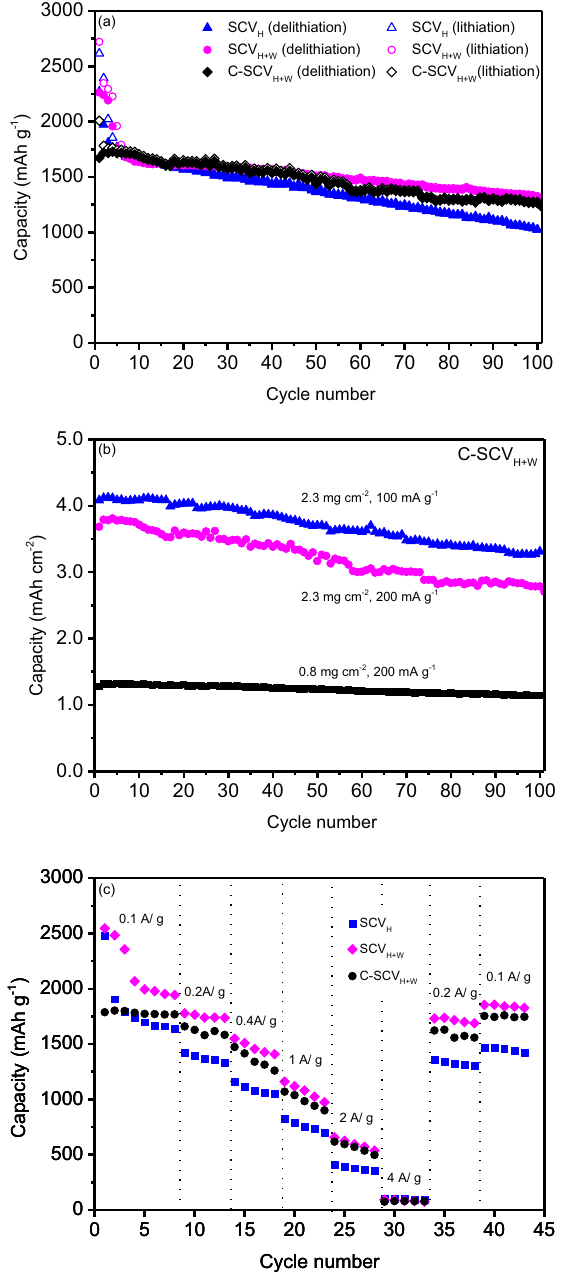
Figure 8. ( a ) Cycling performance of specific discharge (lithiation)/charge (delithiation) capacity for SCV H , SCV H + W and C-SCV H + W conducted at current density 200 mA g − 1 between 0.002 V to 1.5 V. ( b ) Areal charge (delithiation) capacity comparison for C-SCV H + W of varied loading (0.8/2.3 mg cm − 2 ) conducted at current density 100 and 200 mA g − 1 between 0.002 V to 1.5 V. ( c ) Charge (delithiation) capability of SCV H , SCV H + W and C-SCV H + W at various charge and discharge rates conducted at current density 0.1, 0.2, 0.4, 1.0, 2.0, 4.0 then 0.2, 0.1 A g − 1 between 0.002 V to 1.5